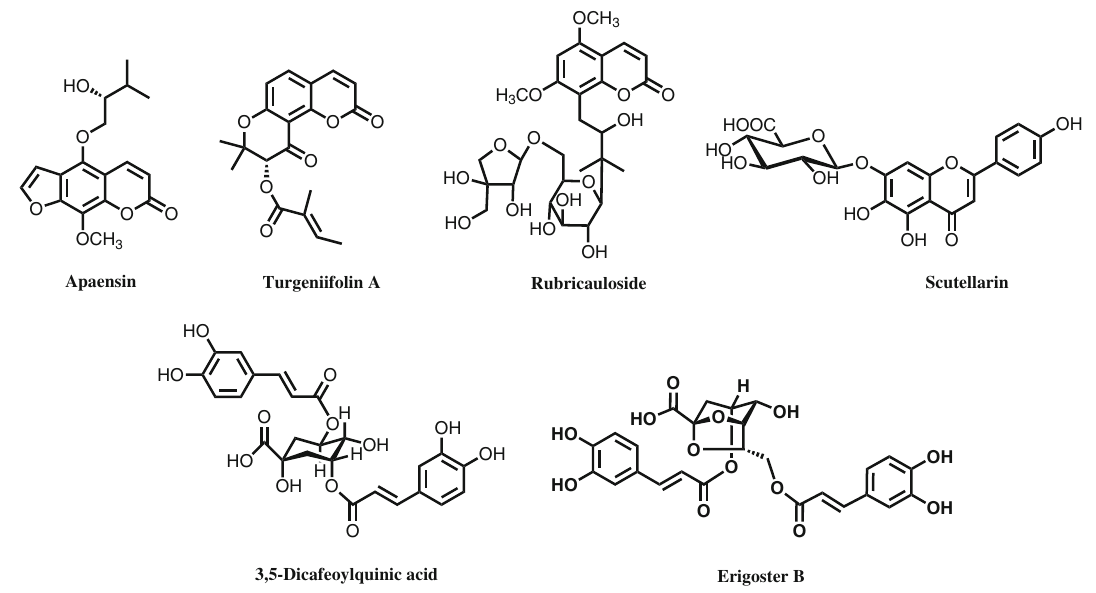
Fig. 4 Representative chemical constitutes of Umbelliferae species and Erigeron